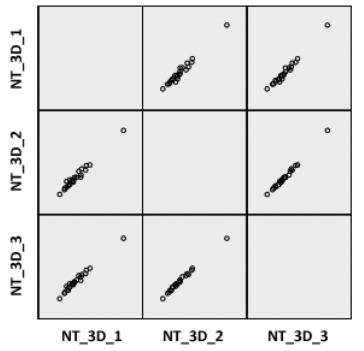
Fig. 7 - Matric scatter plot for three trials proposed 3D ultrasonic NT measurement (Sample Size N =